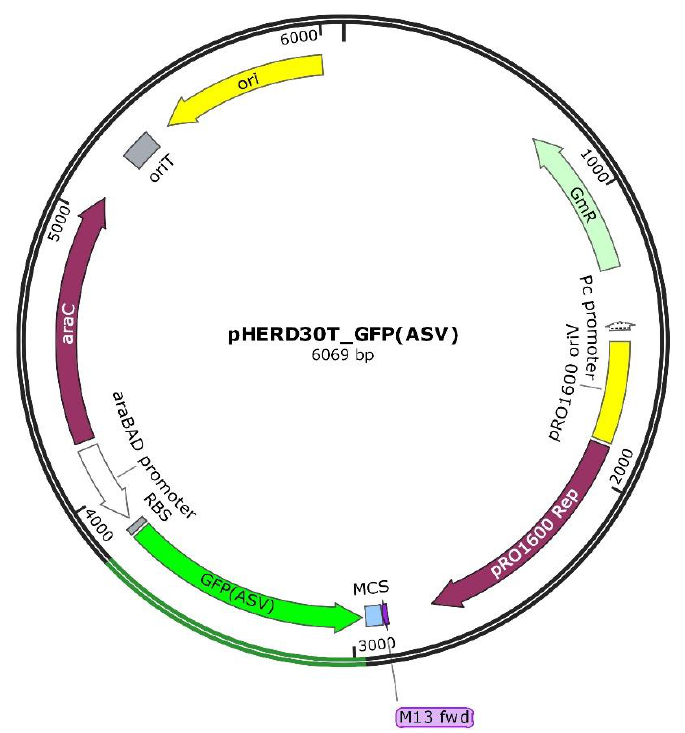
Figure 1. The recombinant pHERD30T_GFP(ASV) vector. The recombinant pHERD30T vector, encoding the GFP(ASV) protein was obtained by cloning the gfp(ASV) gene into the original vector using the In-Fusion HD Cloning Plus kit; the vector map was designed with the software SNAPGENE v. 4.2.6.